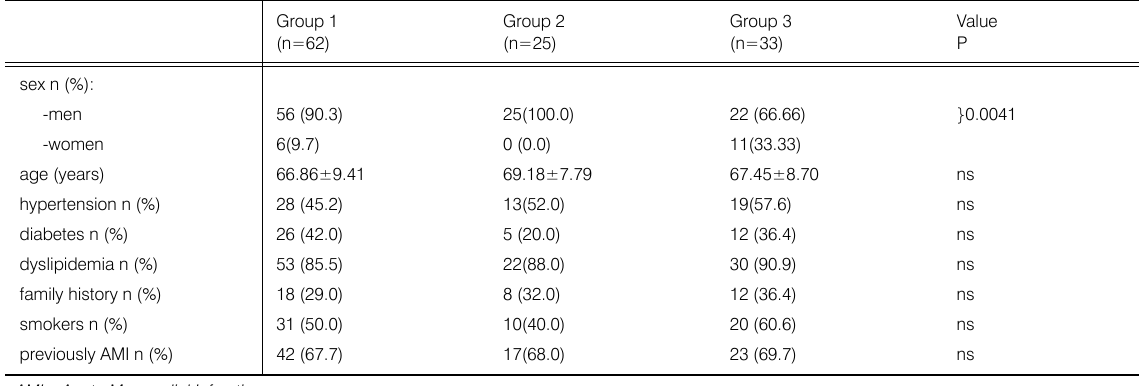
Table 2. Demographic